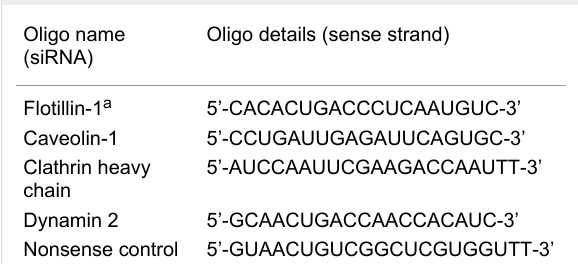
Table 2: Sequences of siRNAs used for transfection with Lipofecta- mine™ 2000 transfection